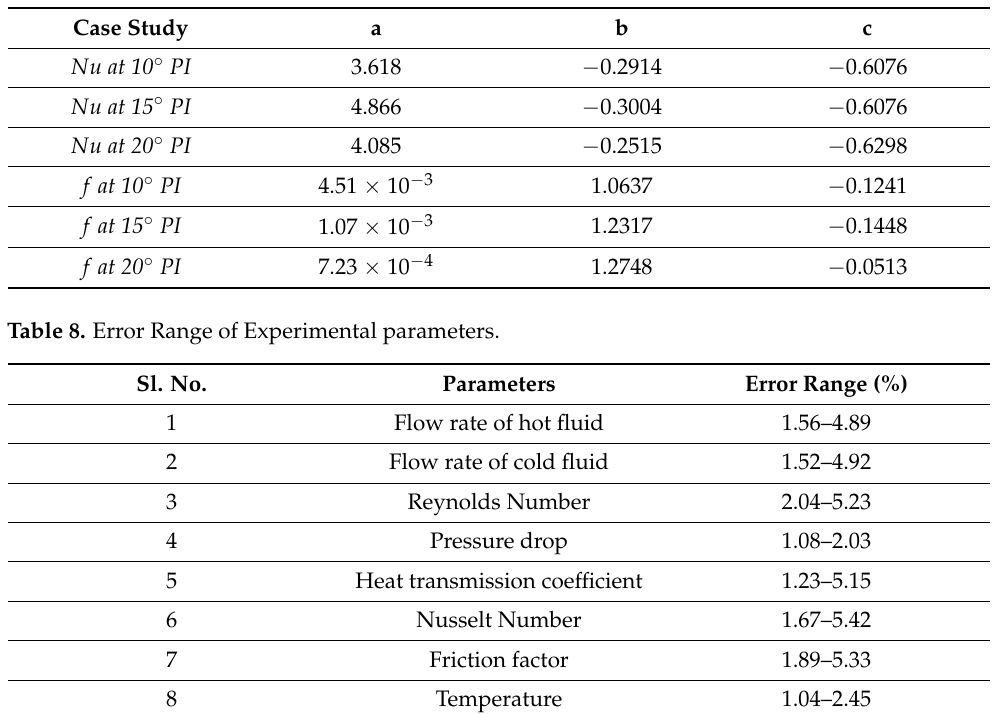
Table 7. Correlation constants of Nu and f .